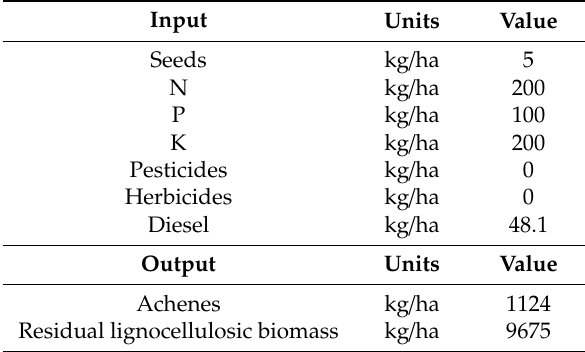
Table 2. Input and output data for cardoon cultivation [19].